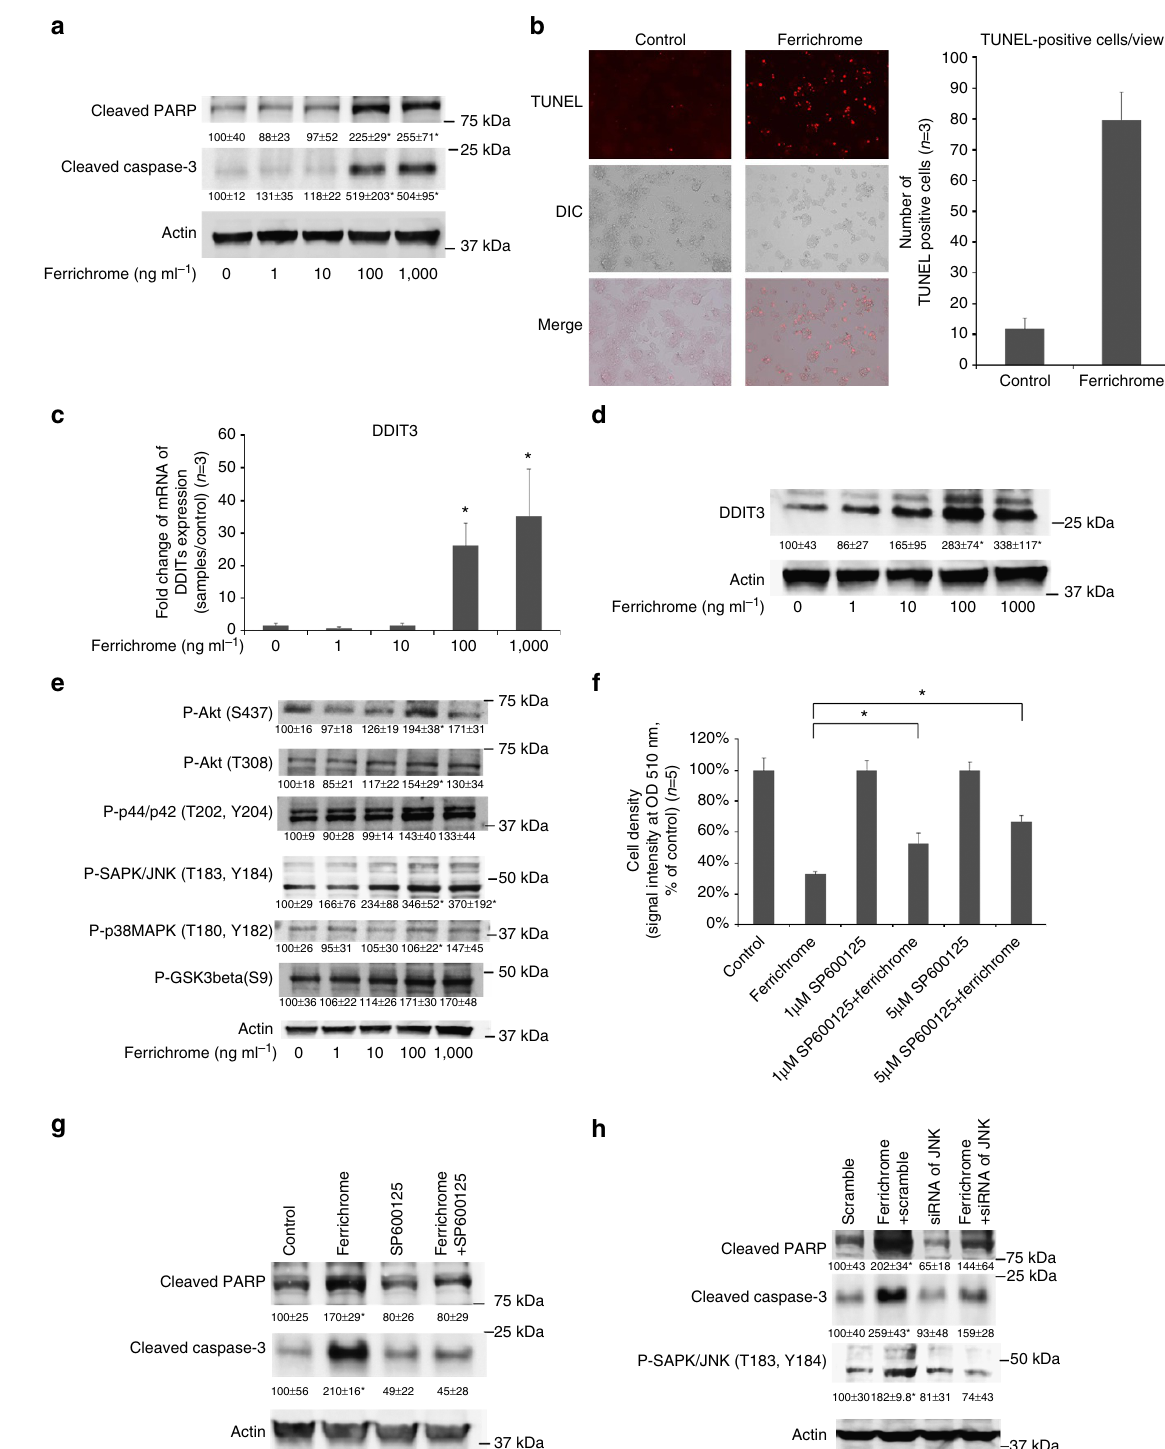
Figure 7 | Ferrichrome-induced apoptosis is mediated by the ER stress-responsive-JNK pathway. The expression levels of cleaved caspase-3 and PARP in SW620 cells were increased by ferrichrome treatment in a dose-dependent manner ( a ). TUNEL-positive cells in SW620 cells were increased by ferrichrome treatment (0.1 m gml (cid:2) 1 ). The photographs were taken under a high-power view ( (cid:3) 200) ( b ). DDIT3 expression was assessed using a quantitative RT–PCR ( c ) and western blotting ( d ). DDIT3 was found to be highly induced (in a dose-dependent manner) in ferrichrome-treated SW620 cells. A western blotting analysis revealed the activation of the JNK signal transduction pathway in ferrichrome-treated (0.1 m gml (cid:2) 1 ) SW620 cells ( e ). The tumour-suppressive effect was reduced by the inhibition of JNK activation ( f ). AWestern blotting analysis showed the elimination of cleaved caspase-3 and the induction of PARP in ferrichrome-treated (0.1 m gml (cid:2) 1 ) SW620 cells by the treatment of SP600125 ( g ) or siRNA of JNK ( h ). * P o 0.05 by Student’s t -test. The error bars show the s.d. ( a – e and g , n ¼ 3; f , n ¼ 5). The original unprocessed scans of the Western blots are shown in Supplementary Fig.